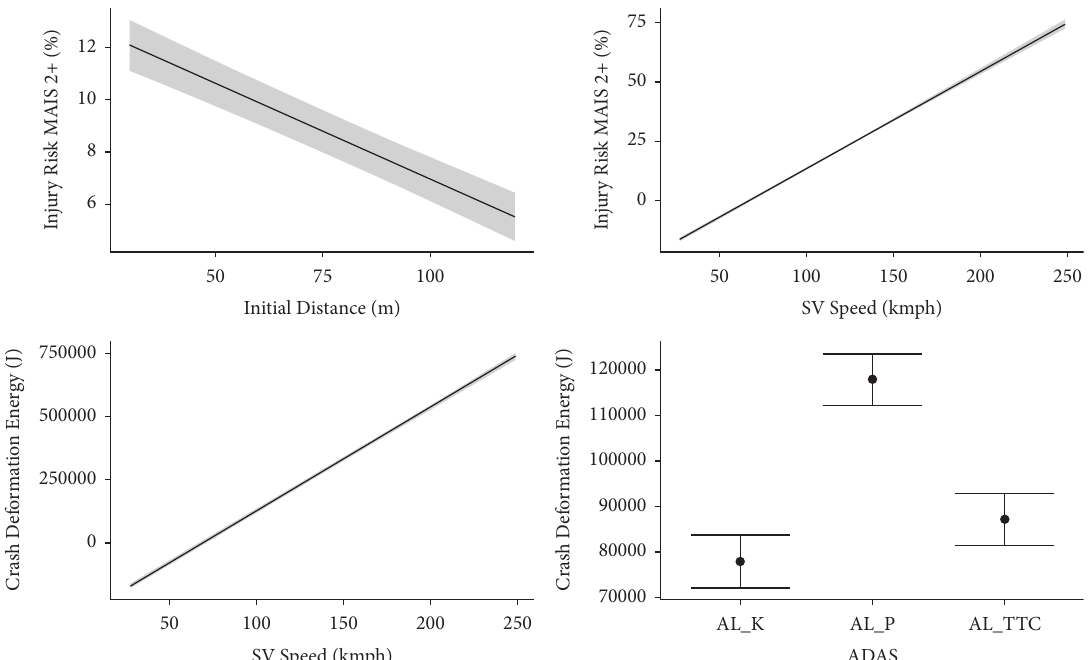
Figure 13: Effect plots for two important parameters resulted in the energy and injury models (confidence interval of 95%).